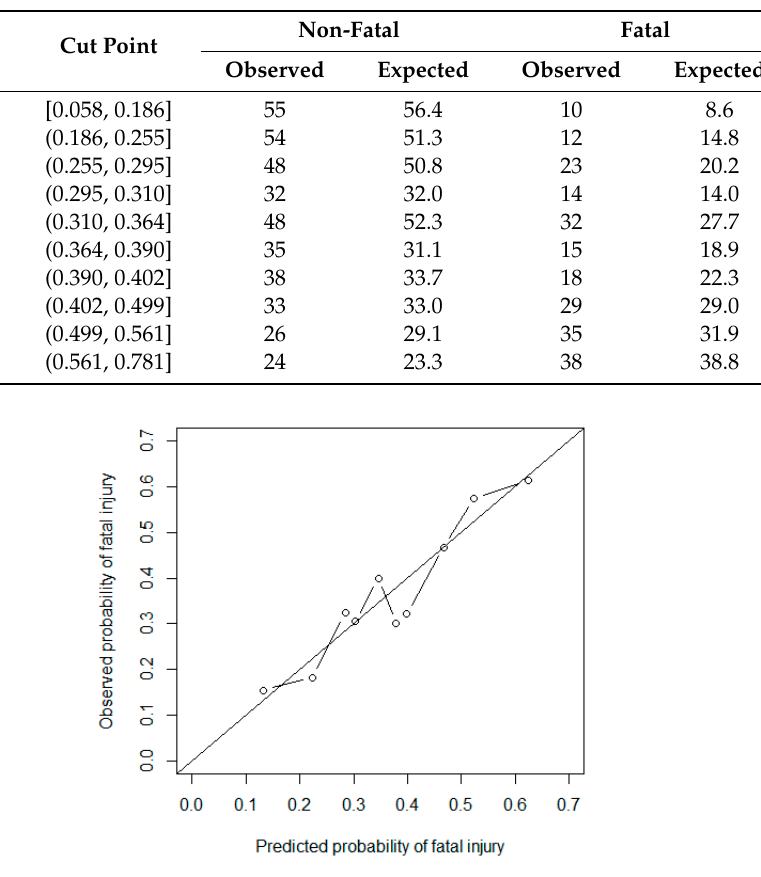
Table 5. Observed and estimated frequencies within ten deciles of risk for fatal and non-fatal accidents.